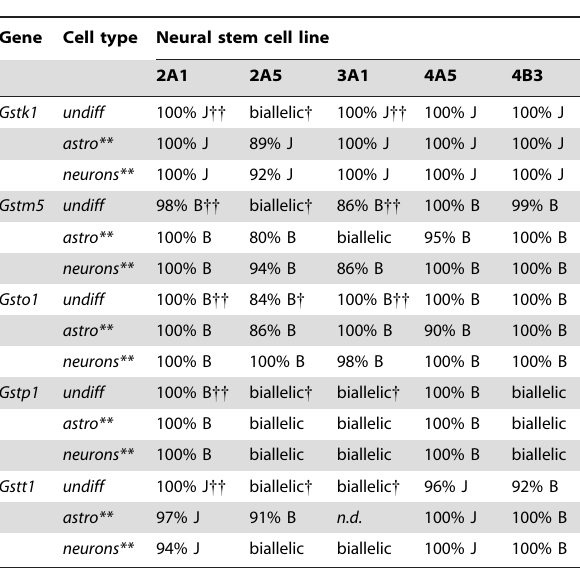
Table 1. RT-PCR analysis of allele-specific expression of the Gst gene family in undifferentiated NSCs, and following differentiation to neurons and